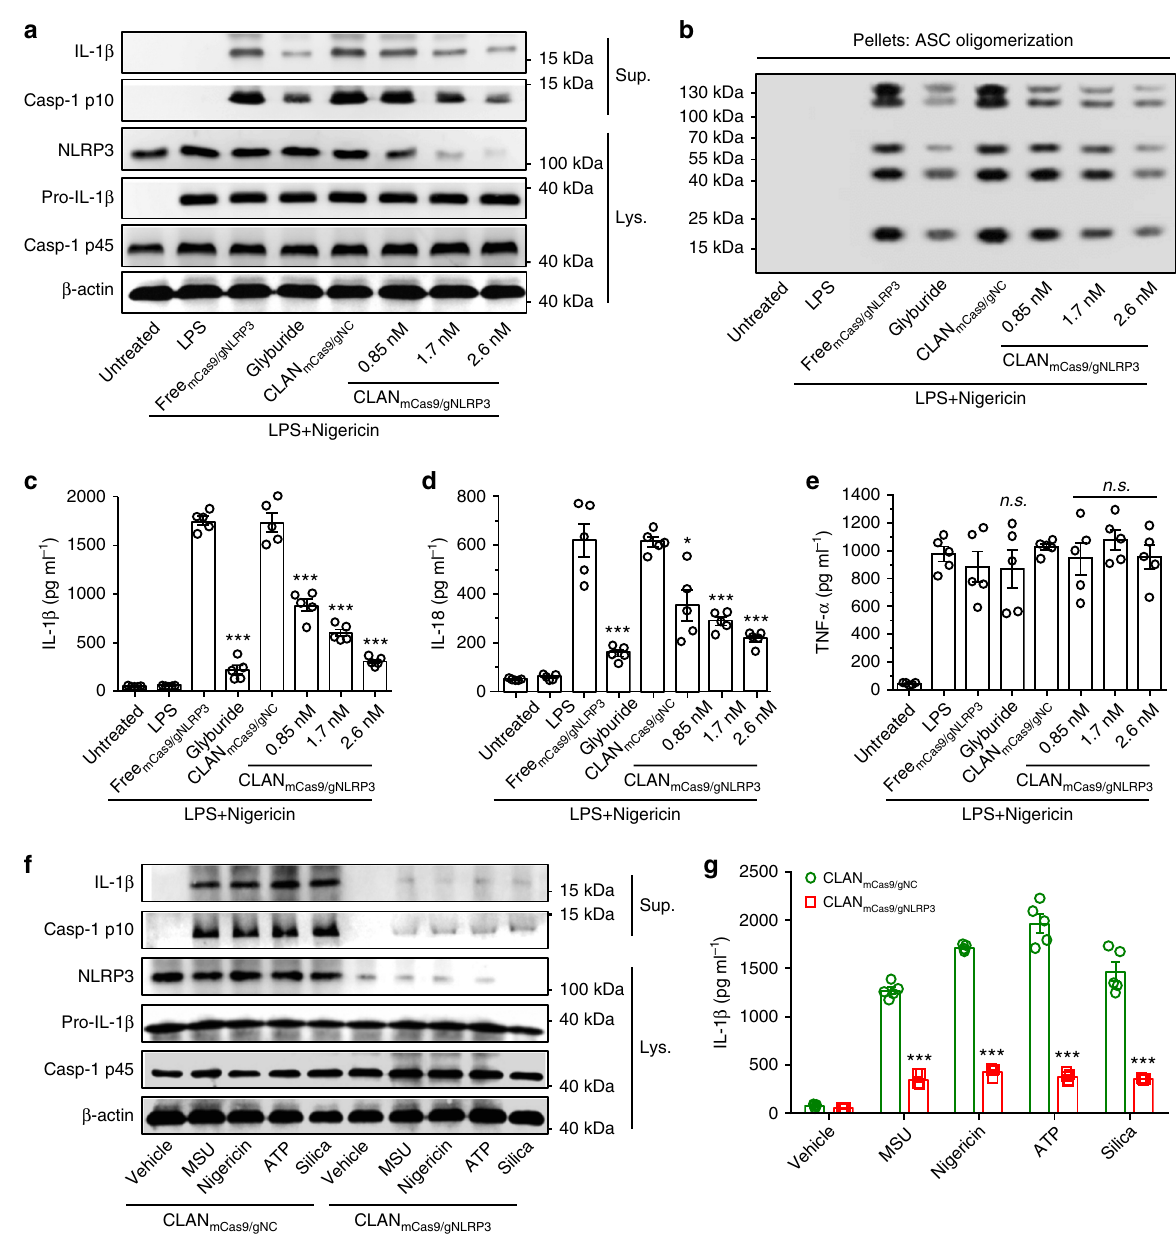
Fig. 3 CLAN mCas9/gNLRP3 -mediated NLRP3 knockout and in fl ammasome inactivation in vitro. a , b Immunoblot analysis of cell lysates (Lys.) and supernatants (Sup.) ( a ) or cross-linked cytosolic pellets ( b ) from BMDMs transfected with CLAN mCas9/gNLRP3 or other formulations and then primed with LPS and stimulated with nigericin. c – e ELISA of IL-1 β ( c ), IL-18 ( d ), TNF- α ( e ) secretion from BMDMs transfected with CLAN mCas9/gNLRP3 or other formulations and then primed with LPS and stimulated with nigericin. f , g Immunoblot analysis of cell lysates and supernatants ( f ) or ELISA of IL-1 β secretion ( g ) from BMDMs transfected with CLAN mCas9/gNLRP3 or CLAN mCas9/gNC at the dose of 2.6 nM mCas9 and then primed with LPS and stimulated with MSU, nigericin, ATP or silica. The data are representative of three independent experiments ( a , b , f ) or are shown as the means ± SEM of n = 5 ( c – e , g ). Two-way ANOVA ( c – e ) Student ’ s t -test ( g ) * P < 0.05, *** P < 0.001, n.s . not signi fi and all mice in the CLAN mCas9/gNLRP3 -treated groups (1, 2, and 4